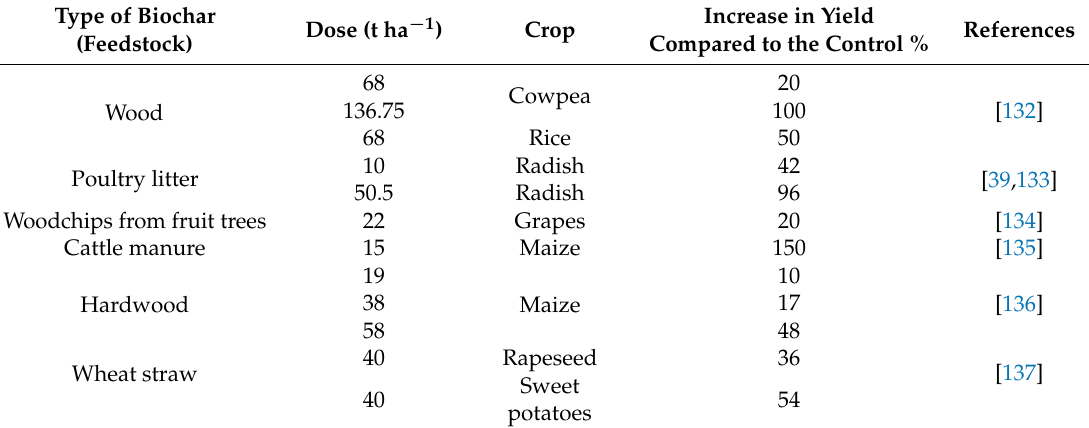
Table 7. Effect of biochar application on the yield of selected